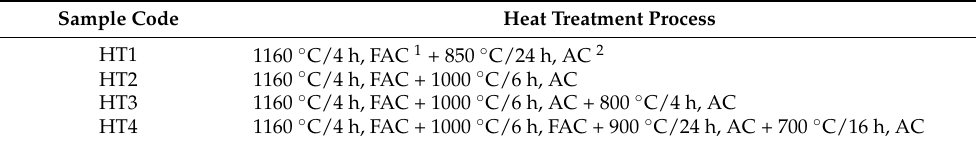
Table 1. Heat treatment processes for IN939